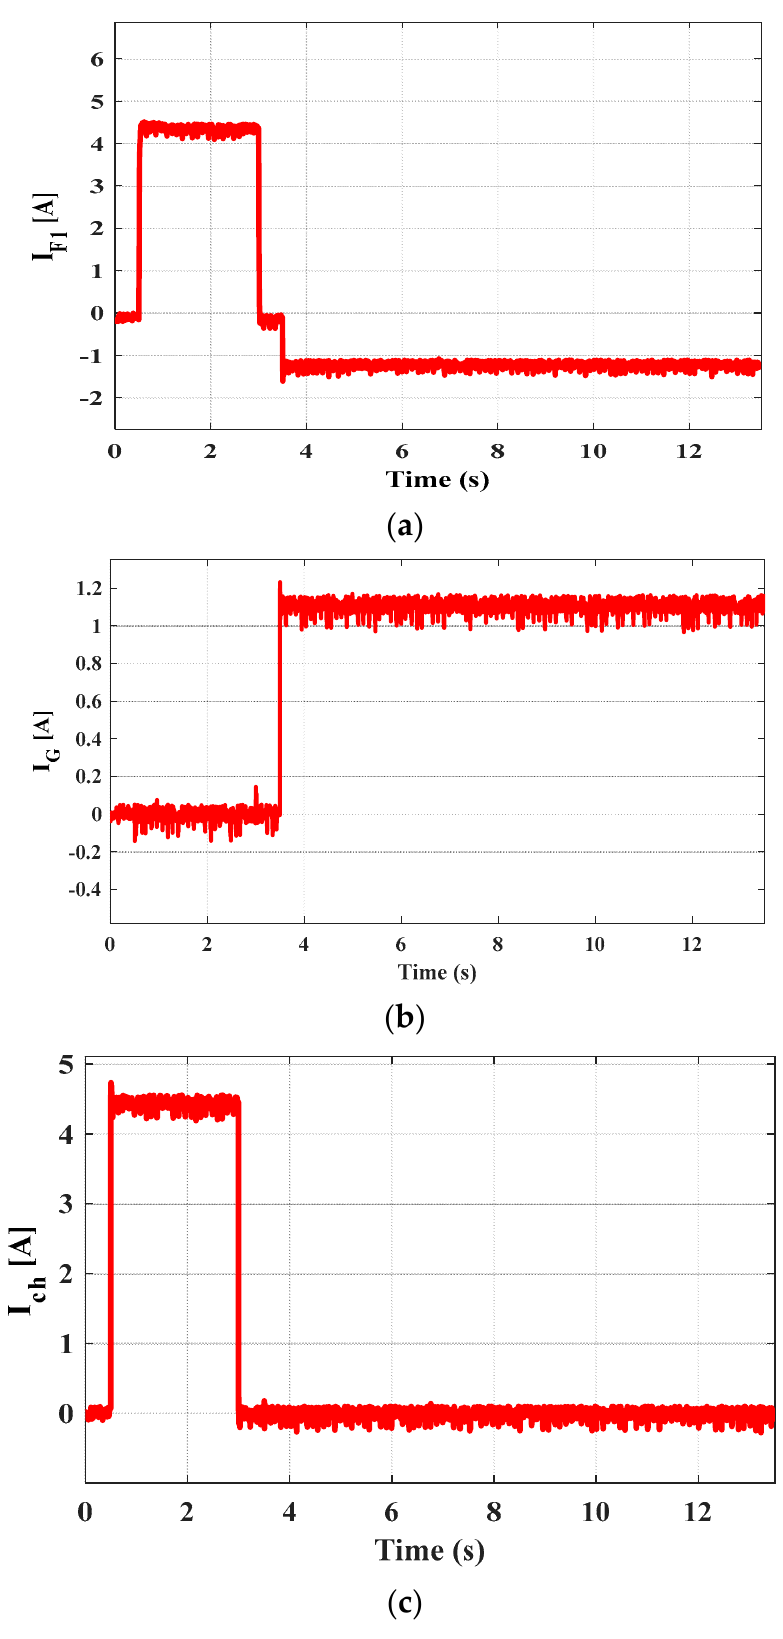
Figure 20. Experimental setup: ( a ) FESS current, ( b ) grid current, and ( c ) charger current.